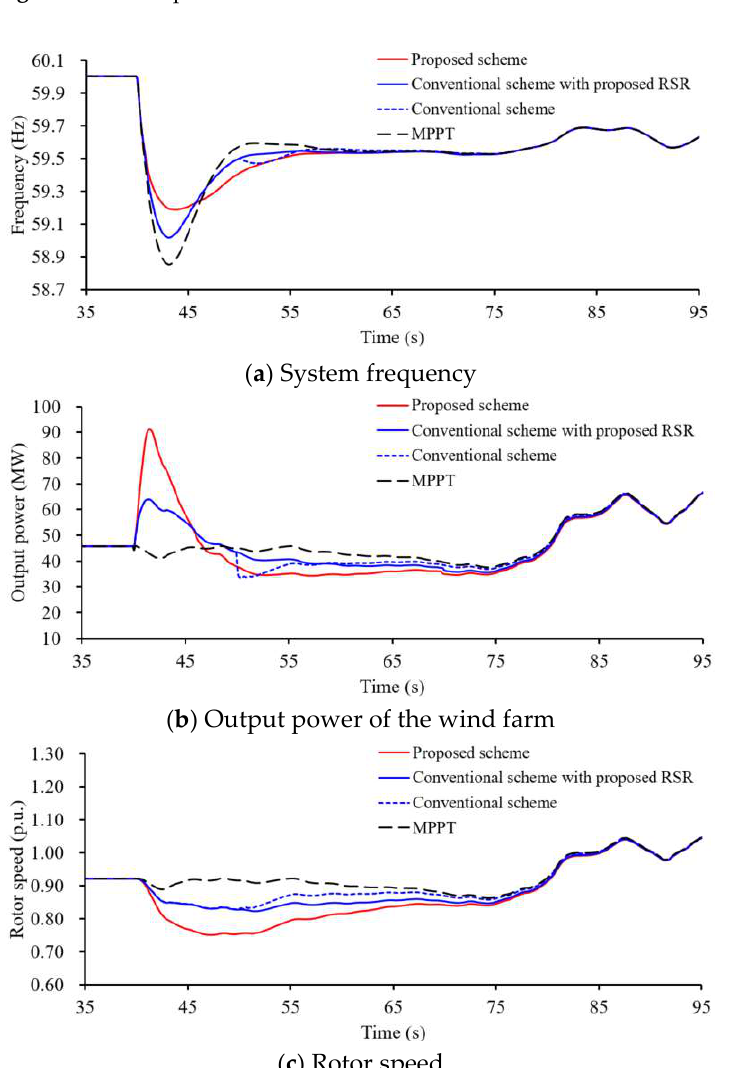
Figure 17. Results for Case 4.